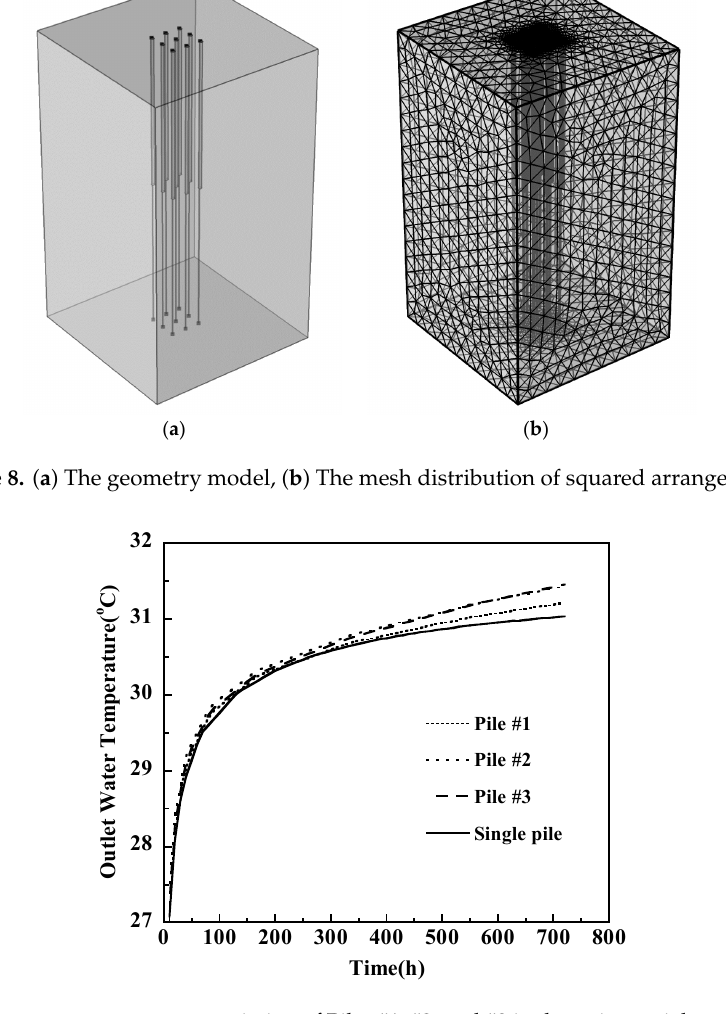
Figure 9. Outlet water temperature variation of Piles #1, #2, and #3 in the quincuncial arrangement and the single